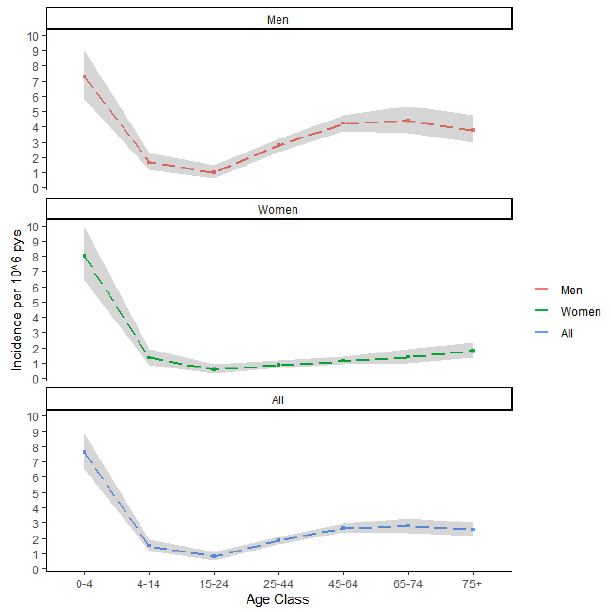
Figure 2. Average age- and sex-specific VL incidence rates over the 2009–2016 period. Incidence rates are expressed per 10 6 person-years and were computed using the Italian census data of 2011. Estimates are represented as dashed lines, while the 95% CI bands are represented as shaded areas.